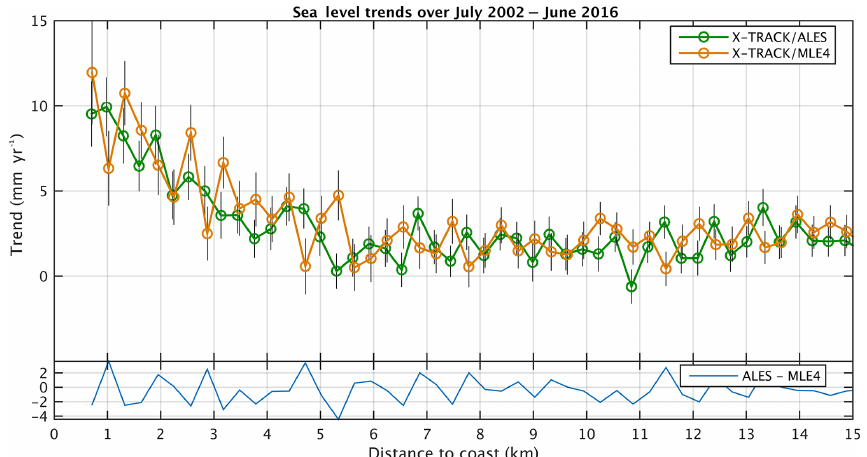
Figure 11. Sea level trends against the distance to the coast for MLE4-based (orange dots) and ALES-based (green dots) SLA data. Vertical bars correspond to trend errors (1 σ ). The light blue curve at the bottom of the panel represents the difference between ALES-based and MLE4-based